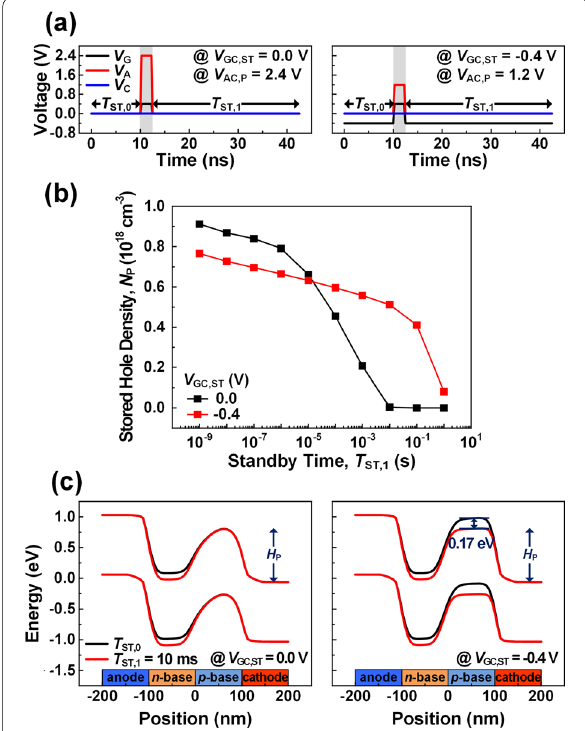
Fig. 3 a Program operation conditions at a V C of 0 V when a V GC,ST is 0.0 V (left) and 0.4 V (right). b N P as a function of T ST,1 at different − V GC,ST of 0.0 V (black line) and 0.4 V (red line). c Energy band − diagrams at 10 ms of T ST,1 when V GC,ST is 0.0 V (left) and 0.4 V −